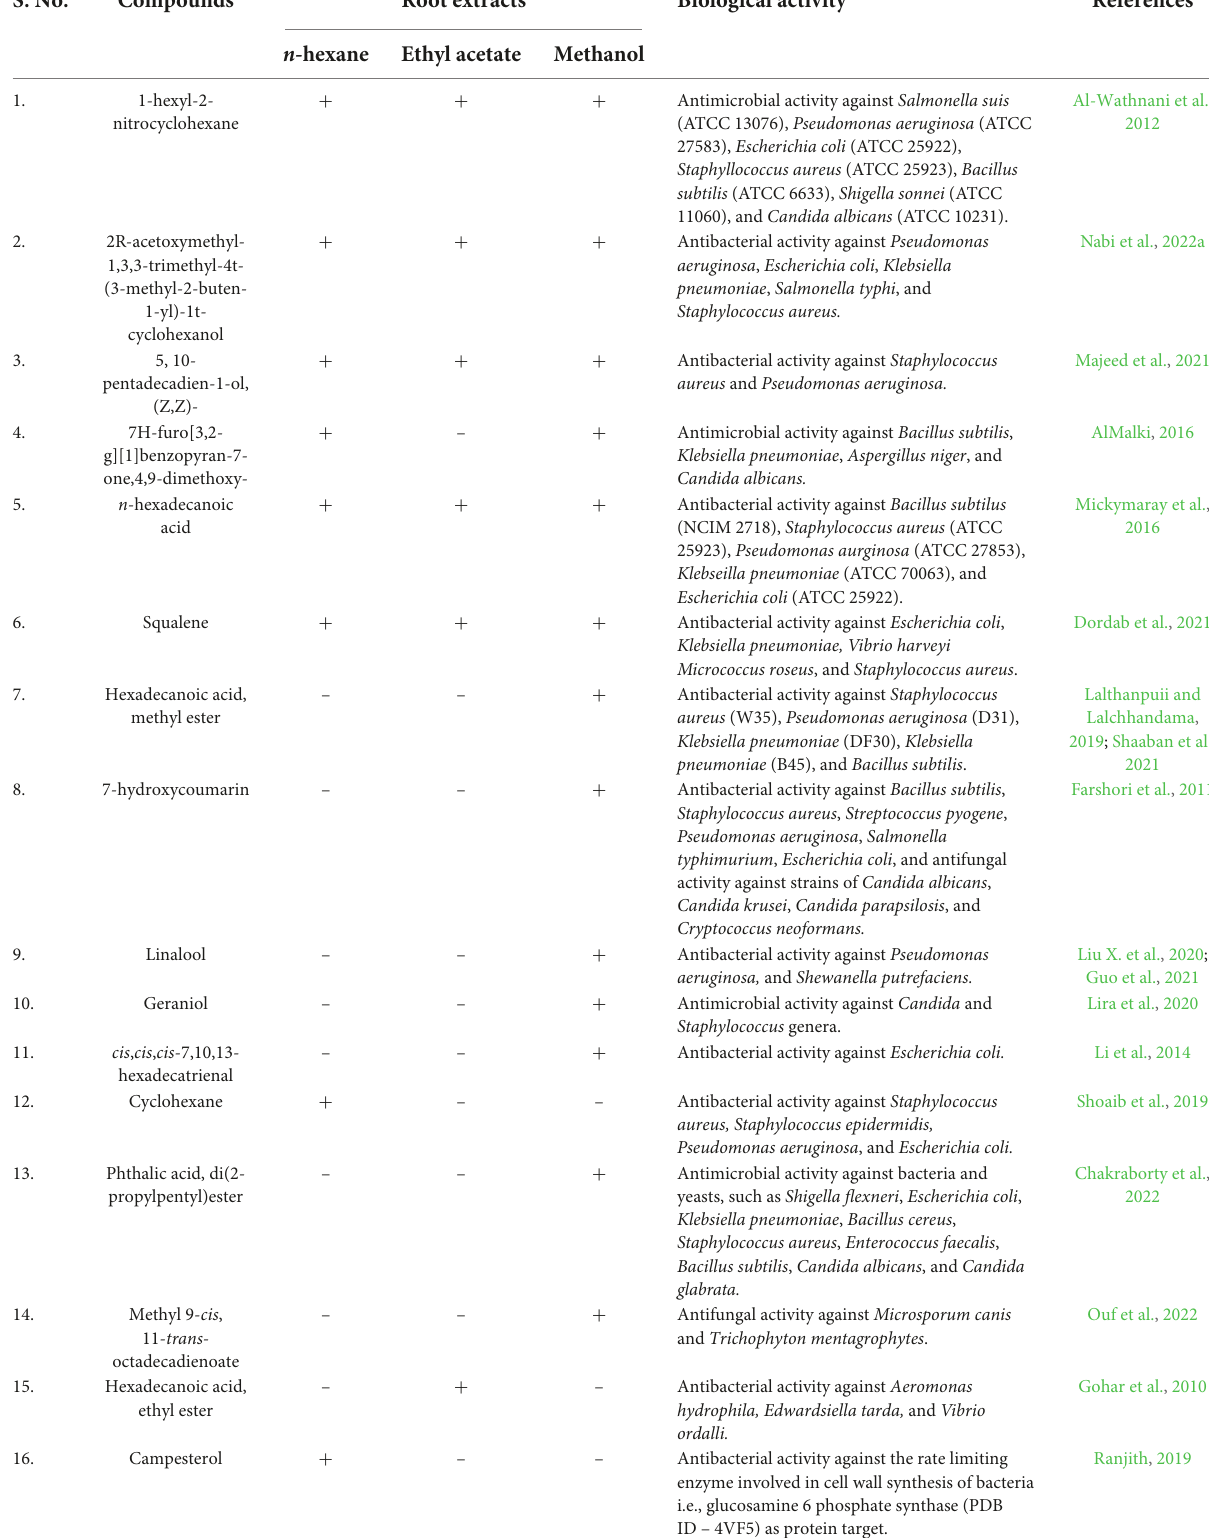
TABLE 4 Bioactive compounds with significant antimicrobial activity. S.